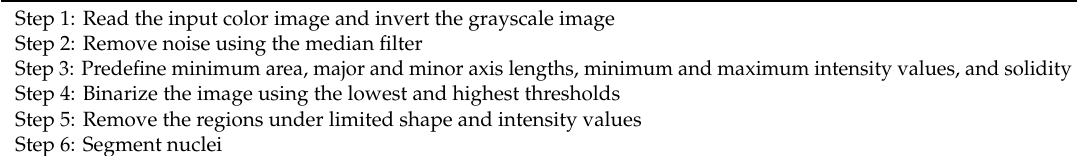
Table 5. Processing steps of the shape-based nuclei detection algorithm.